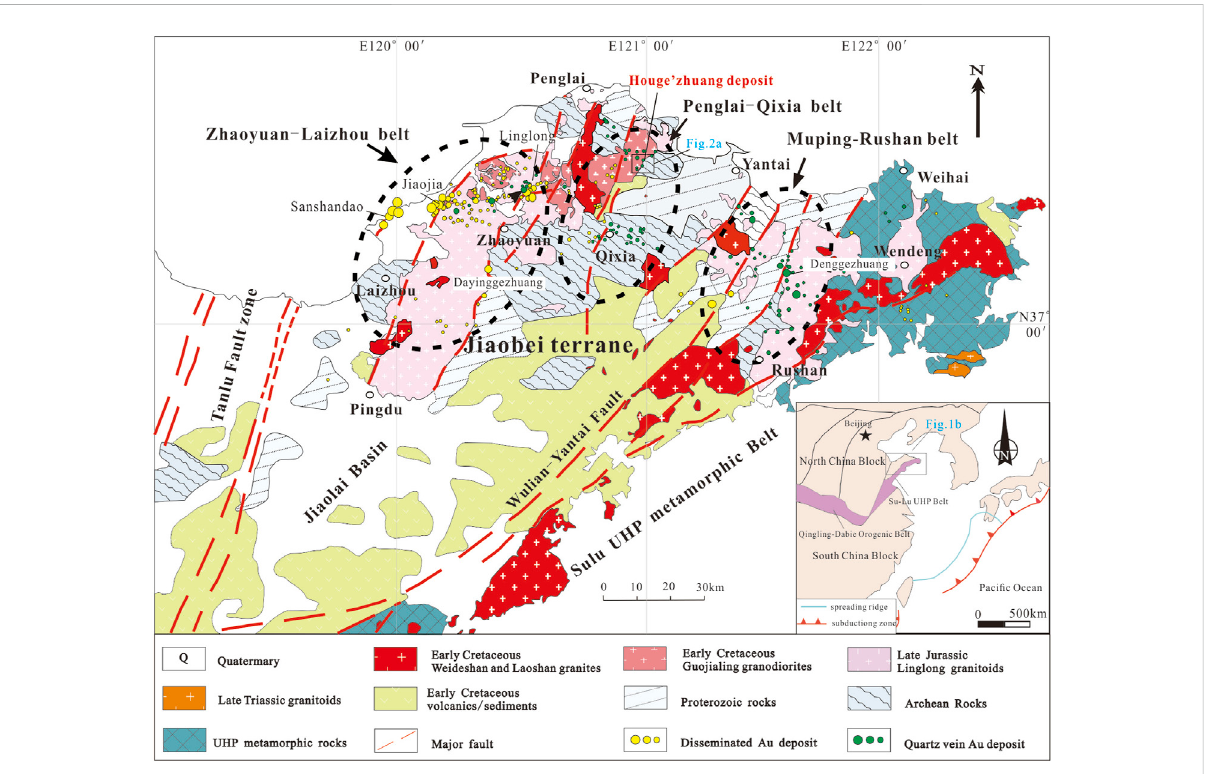
FIGURE 1 Geological map of the Jiaodong gold province showing the major gold deposits and lithological units. Modi fi ed after Wen et al.